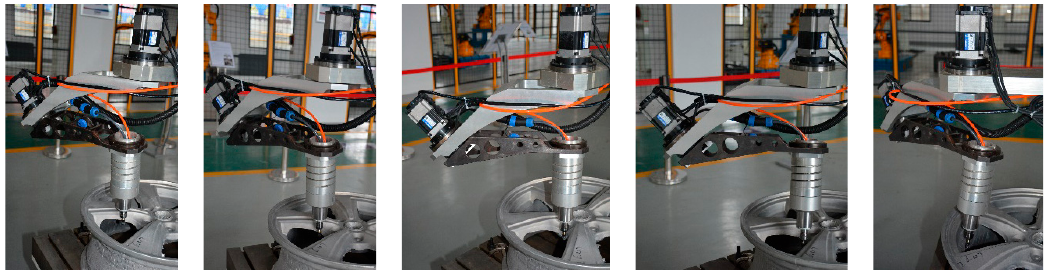
Figure 16. Experimental deburring disc of hub on original experimental platform.